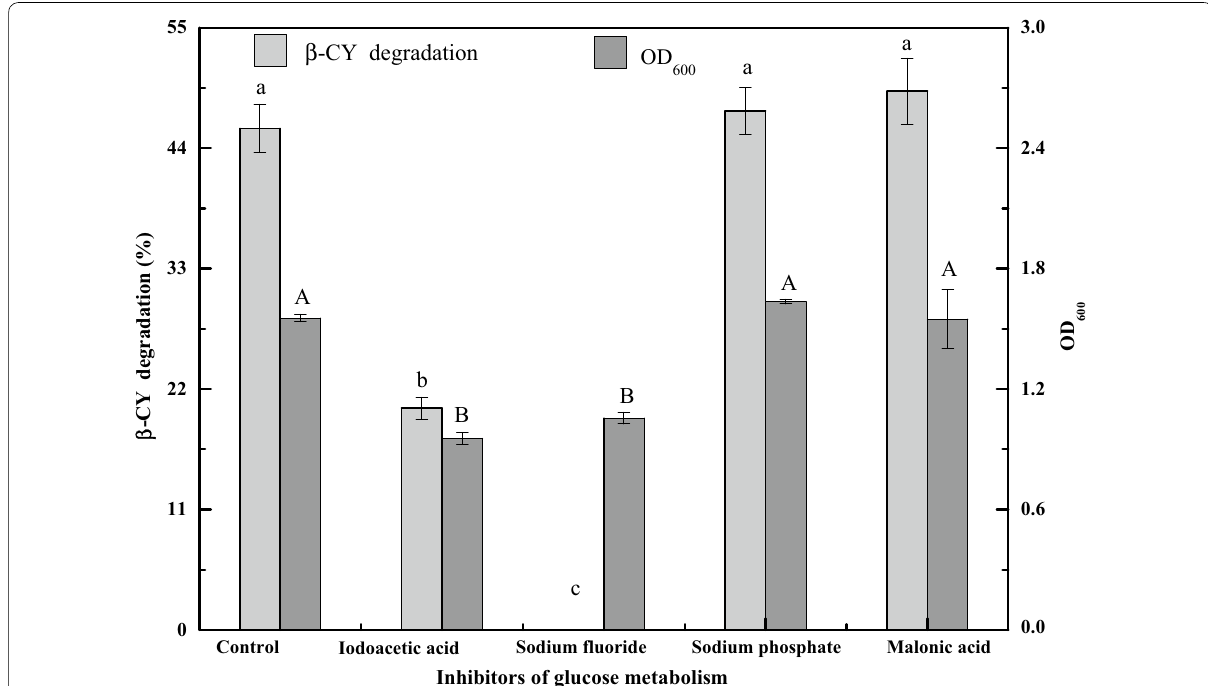
Fig. 1 Effects of glucose metabolism inhibitors on co-metabolic degradation of β-CY by strain B-1. Data are presented as mean deviation of three replicates; the standard deviations are within 5% of the mean. Different letters indicate significant differences ( p <